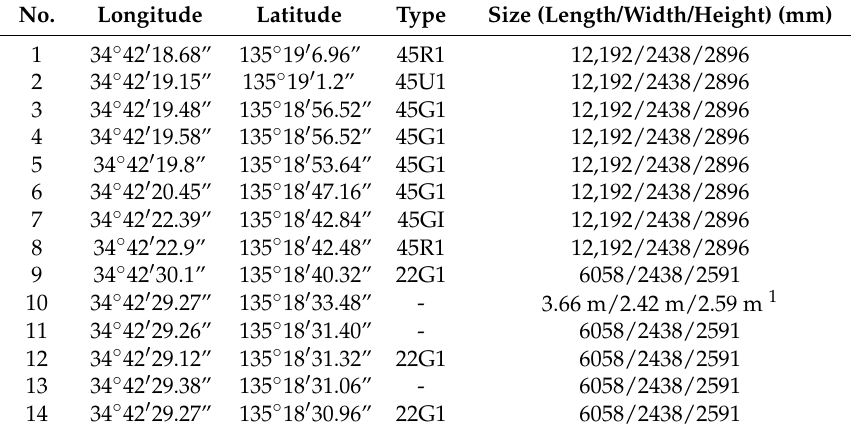
Table 3. Location of the drifted containers.